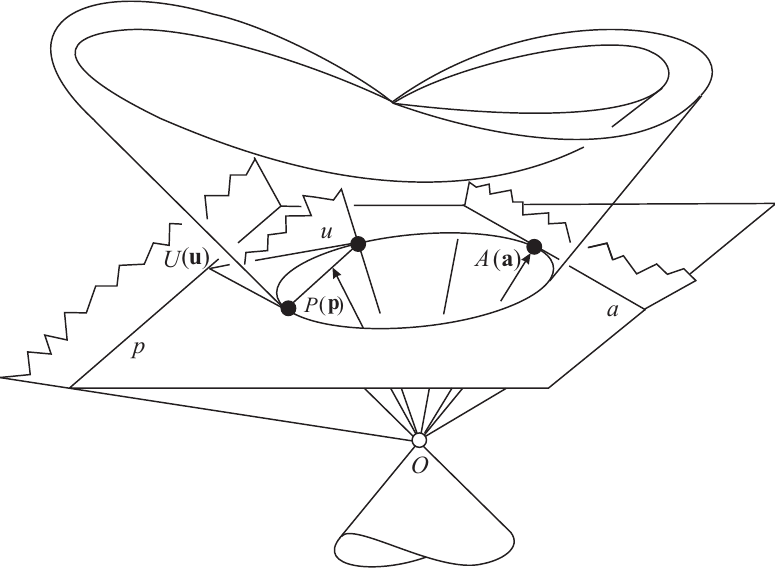
Figure 2. The hyperbolic plane H 2 , embedded into P 2 ⊂ PS 2 by a conic polarity u ( u ) → U ( u ) , p → P , a → A (the Beltrami–Cayley–Klein disc model). Here, we illustrate the projective model of H 2 × R geometry, too. Imagine similarities from the origin O . The logarithm of similarity factor will be the R